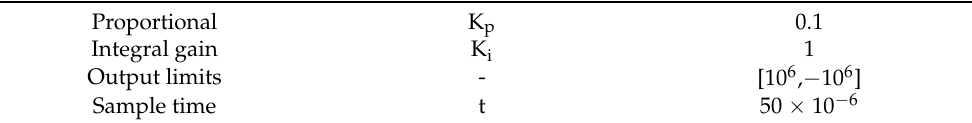
Table 3. Main parameters of the RLC.